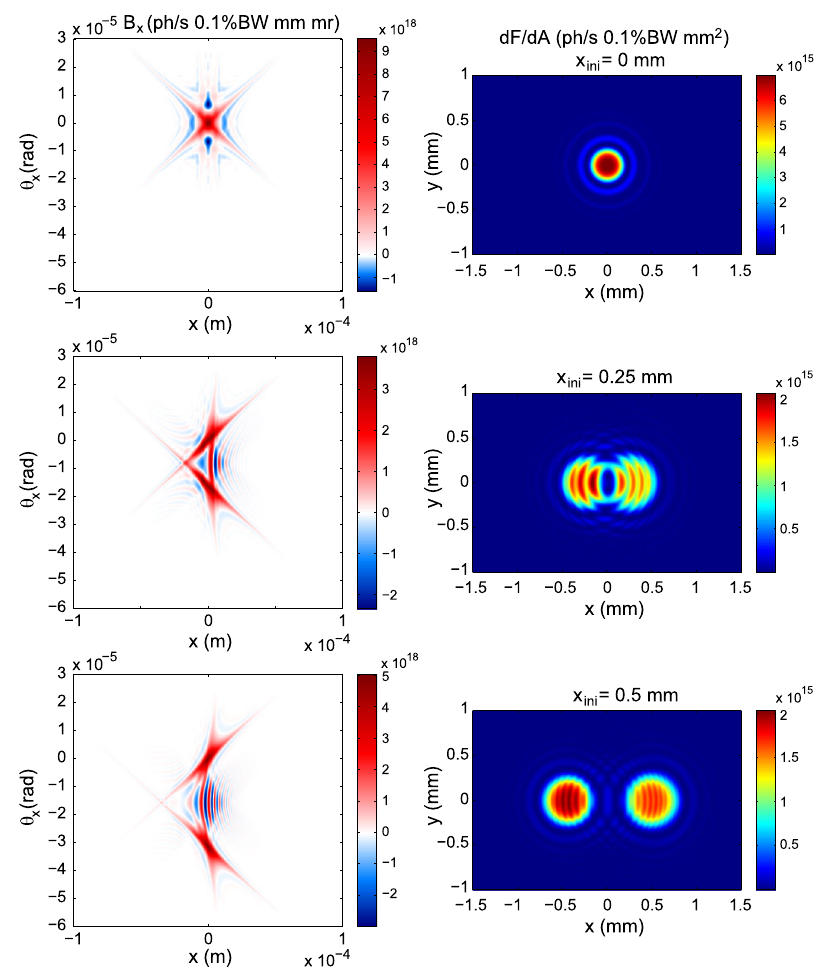
FIG. 14. Radiation of the 1st harmonic on 8 keV energy resonance from the segmented undulator with quadrupole focusing of Fig. 13. Different rows correspond to different trajectory offsets, x ini , as shown. The left column is 2D WDF backpropagated to the center of the undulator, which corresponds to the right column showing the radiation spectral flux density at the detector 30 m away from the undulator